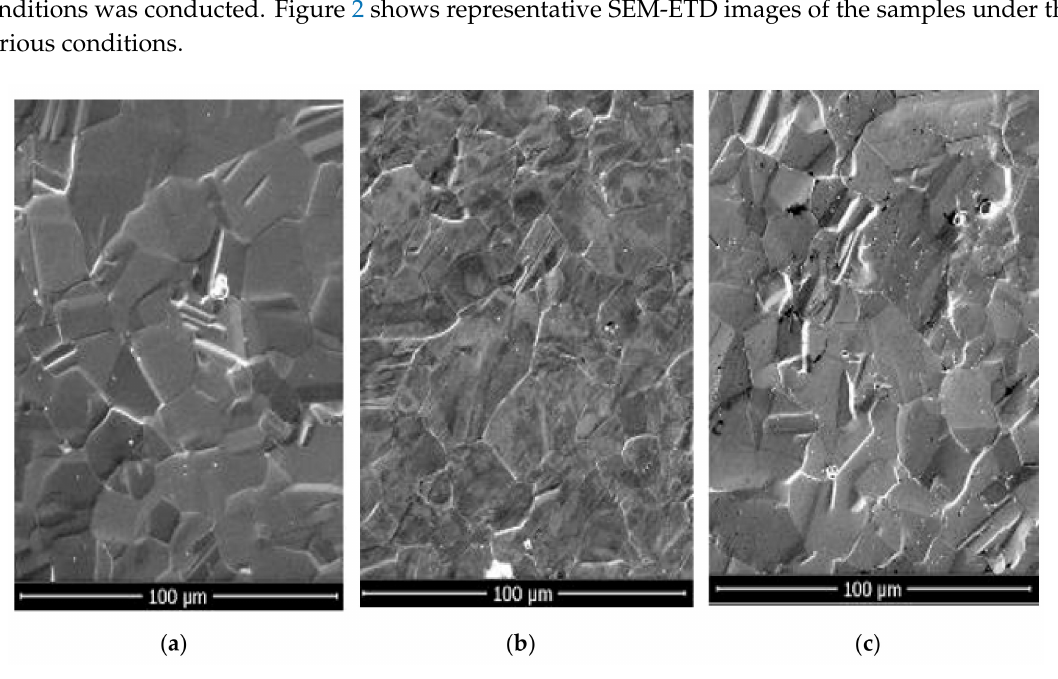
Figure 2. SEM-ETD images of the microstructure of the material under three di ff erent conditions. ( a ) AR condition, ( b ) after stretching the material to 50% of its stretching capacity and ( c ) after the intermediate annealing process (PSTT condition). The images were taken in the RD&ND direction (on the section plane between the rolling direction and the normal